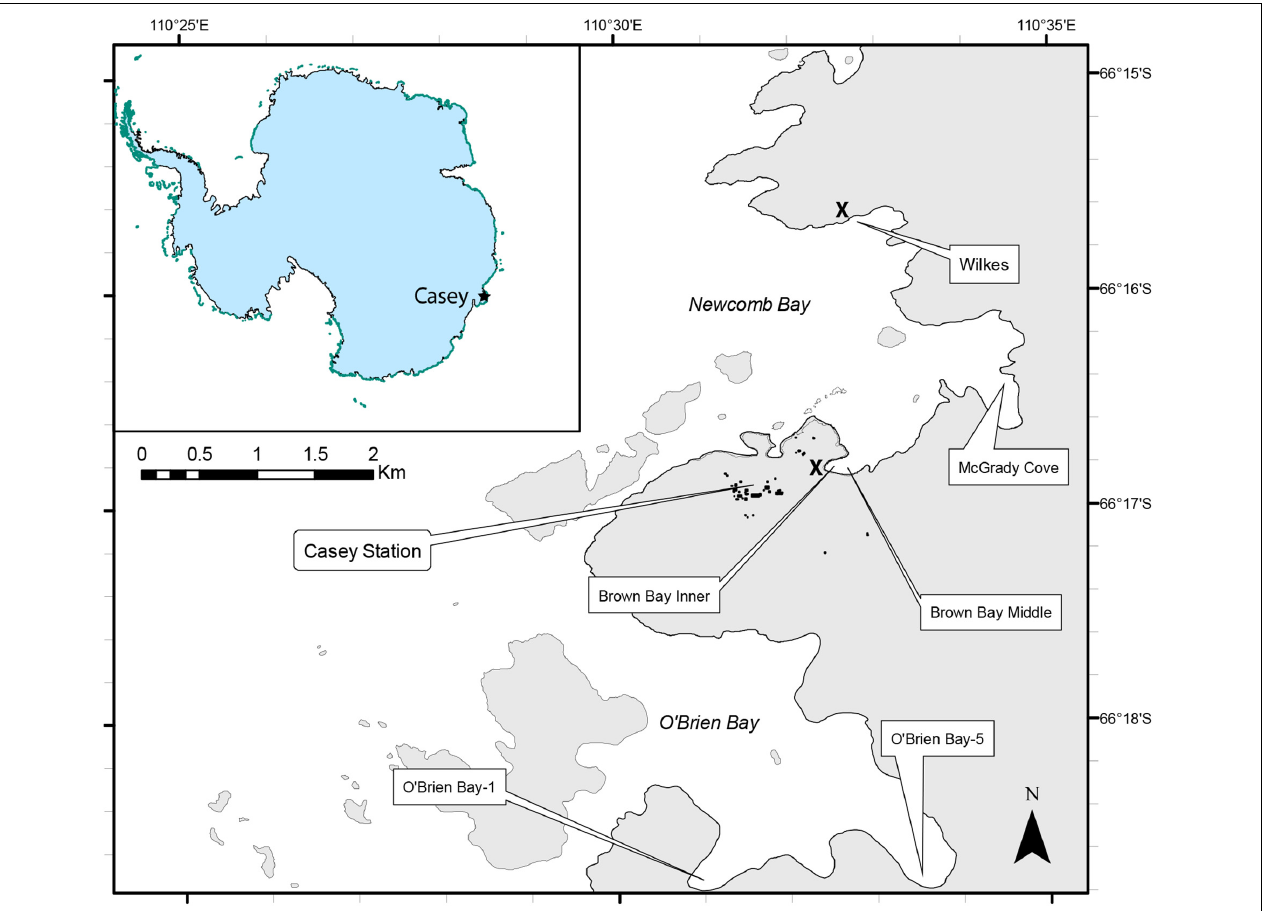
FIGURE 1 | Map of sampling locations around Casey Station, East Antarctica. The approximate locations of the former waste disposal sites at Casey and Wilkes stations are shown by the X